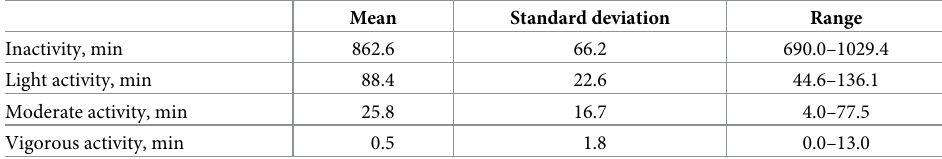
Table 2. Time spent in different levels of PA throughout the day.